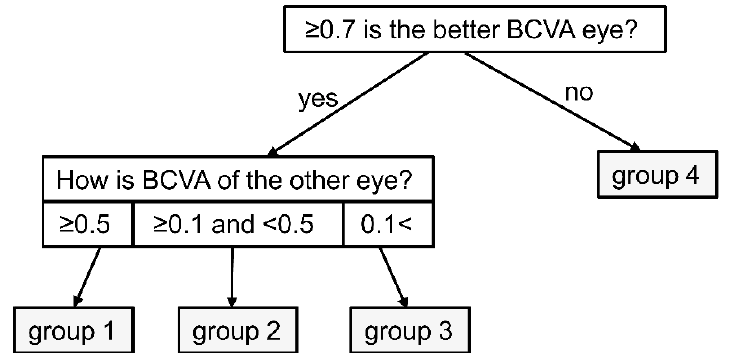
Figure 1. Flowchart of group classification.